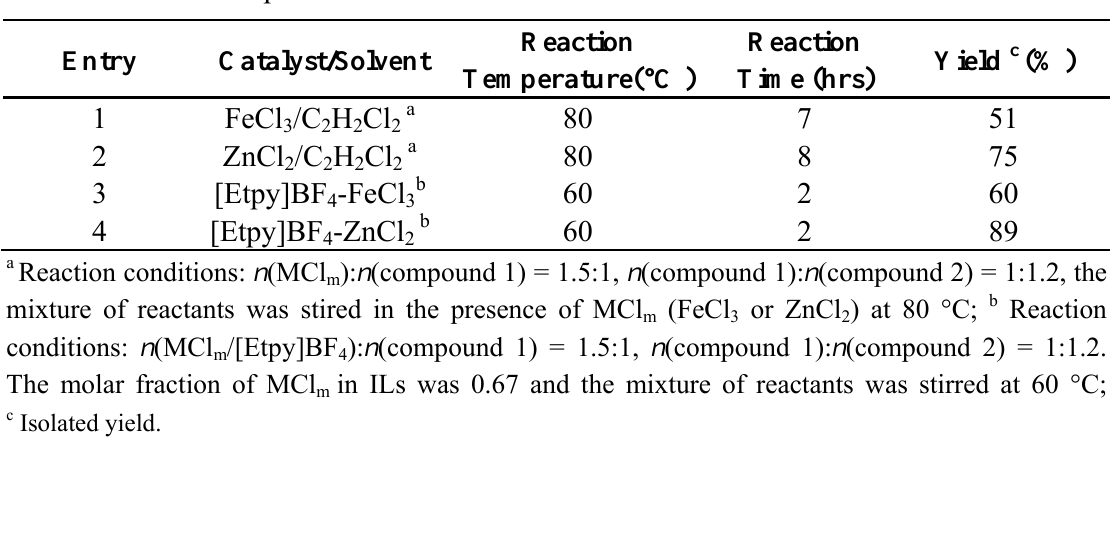
Table 1. Comparative results of Friedel–Crafts reactions in different